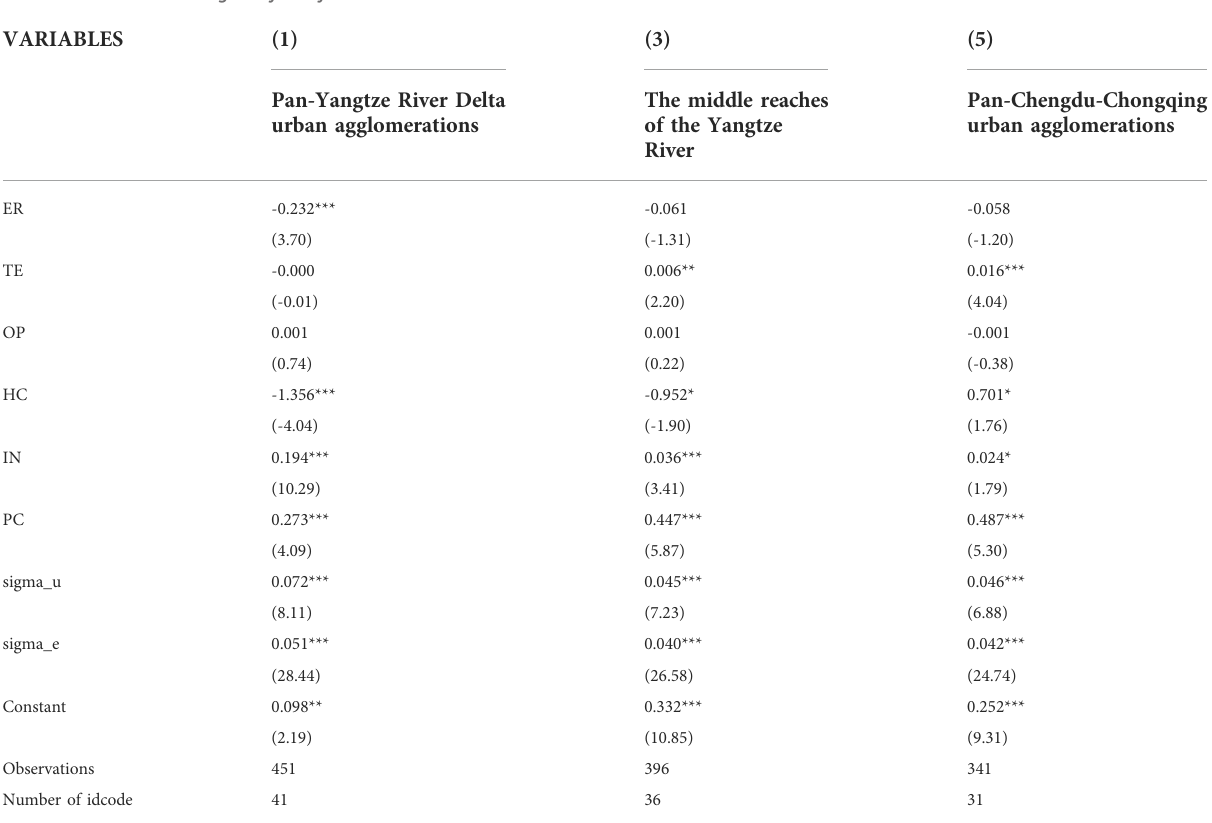
TABLE 5 Results of heterogeneity